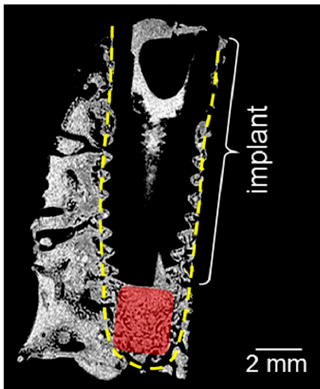
Figure 1. Magnetic resonance (MR) proton density slice image of the bone block containing the implant after a healing time of two weeks. The yellow dotted lines indicate the implant cavity, and the red rectangle shows the region with newly formed tissues, extracted for NMR measurements. The highest proton density is indicated by light gray, the lowest one by black.